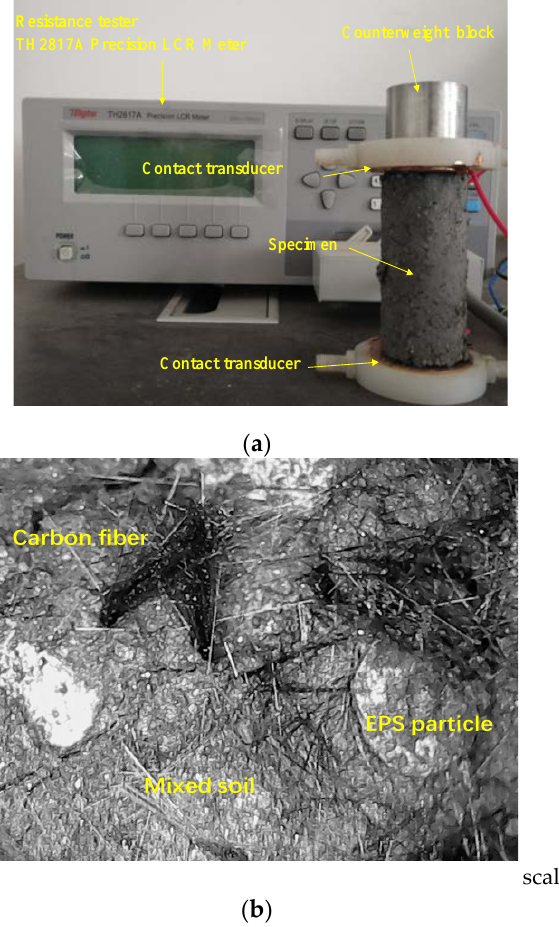
Figure 1. Field measurement to resistance of substrate specimen ( a ) test instruments and specimen; ( b ) micro-structure of substrate, low magnification.